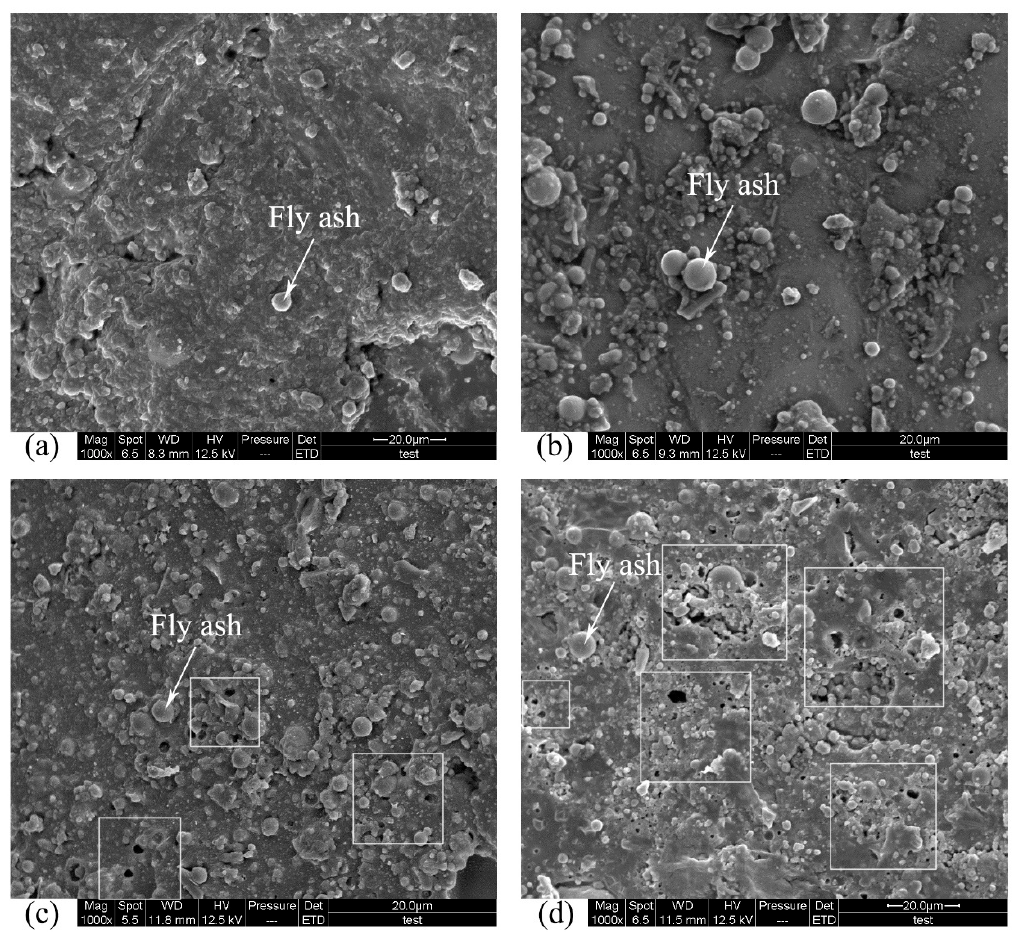
Figure 7. Scanning electron microscopy (SEM) images of the surfaces of lightweight PC specimens after 50 d in sulfuric acid: ( a ) control specimen; ( b ) in pH 2.0 acid; ( c ) in pH 1.0 acid; ( d ) in pH 0.5 acid.